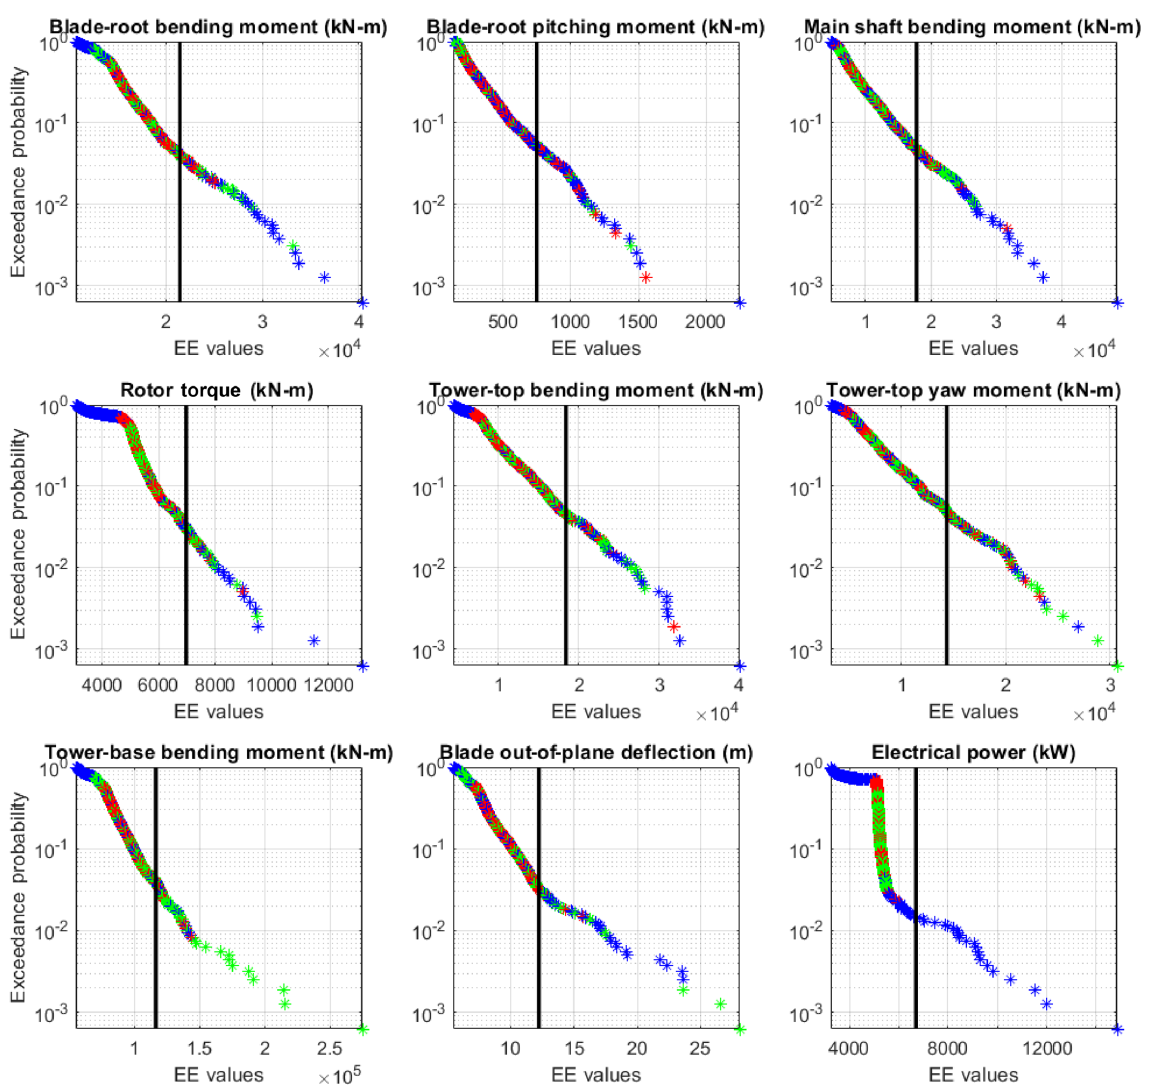
Figure B1. Exceedance probability plot of ultimate load EE values for each of the wind-inflow parameter QoIs across all wind speed bins, input parameters, and simulation points. Black line represents the defined threshold by which outliers are counted for each QoI. Color indicates wind speed bin (blue is below-rated speed, red is near-rated speed, green is above-rated